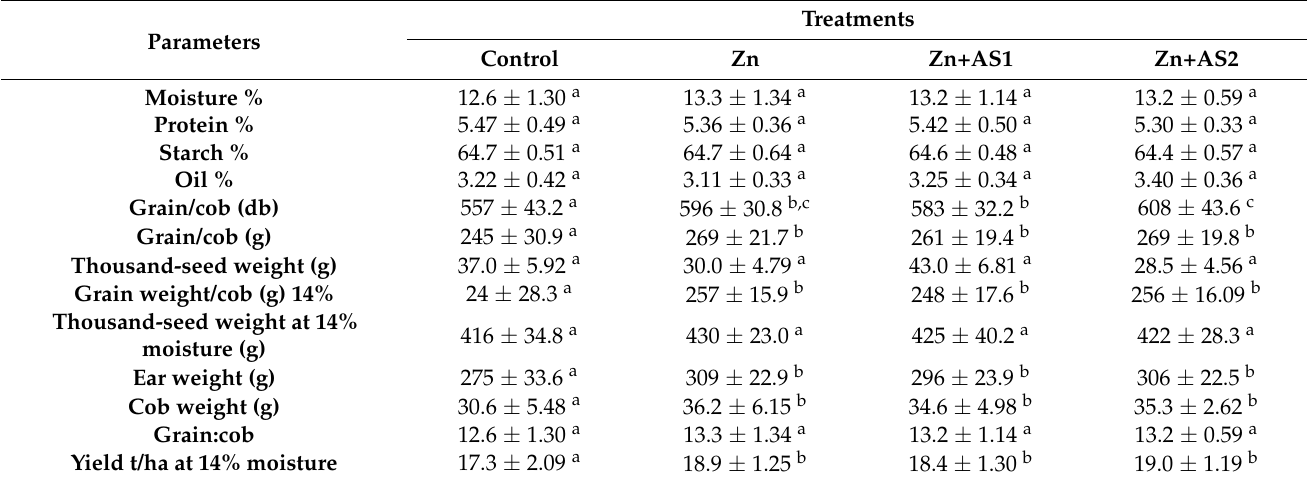
Table 1. The effect of different foliar treatments (Zn, Zn+AS1, and Zn+AS2) on the quality and yield parameters of maize, n = 40 ±